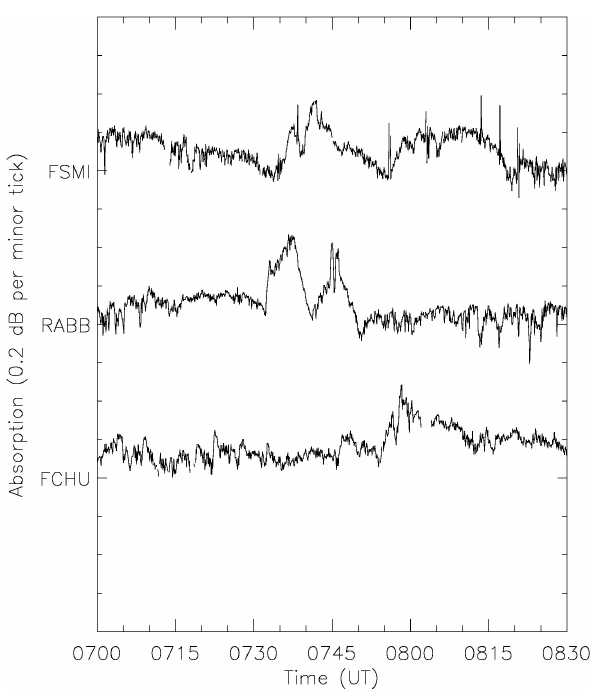
Figure 3 Riometer observations from 0700 to 0830 UT at Fort Smith, Rabbit Lake, and Fort Churchill Fig. 3. Riometer observations from 07:00–08:30 UT at Fort Smith, stations. Rabbit Lake, and Fort Churchill